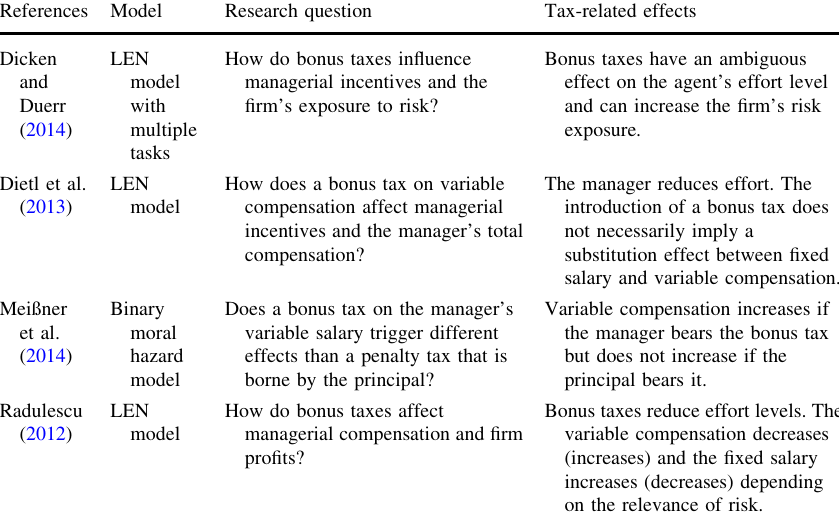
Table 8 Bonus taxes and the design of compensation